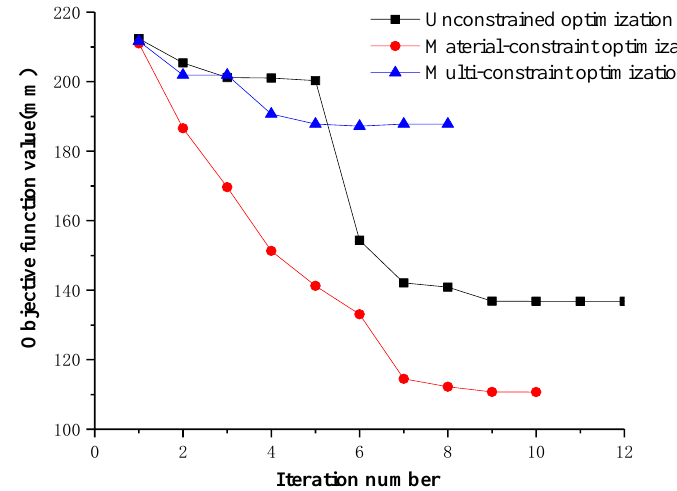
Figure 8. Comparison of three kinds of optimization models.